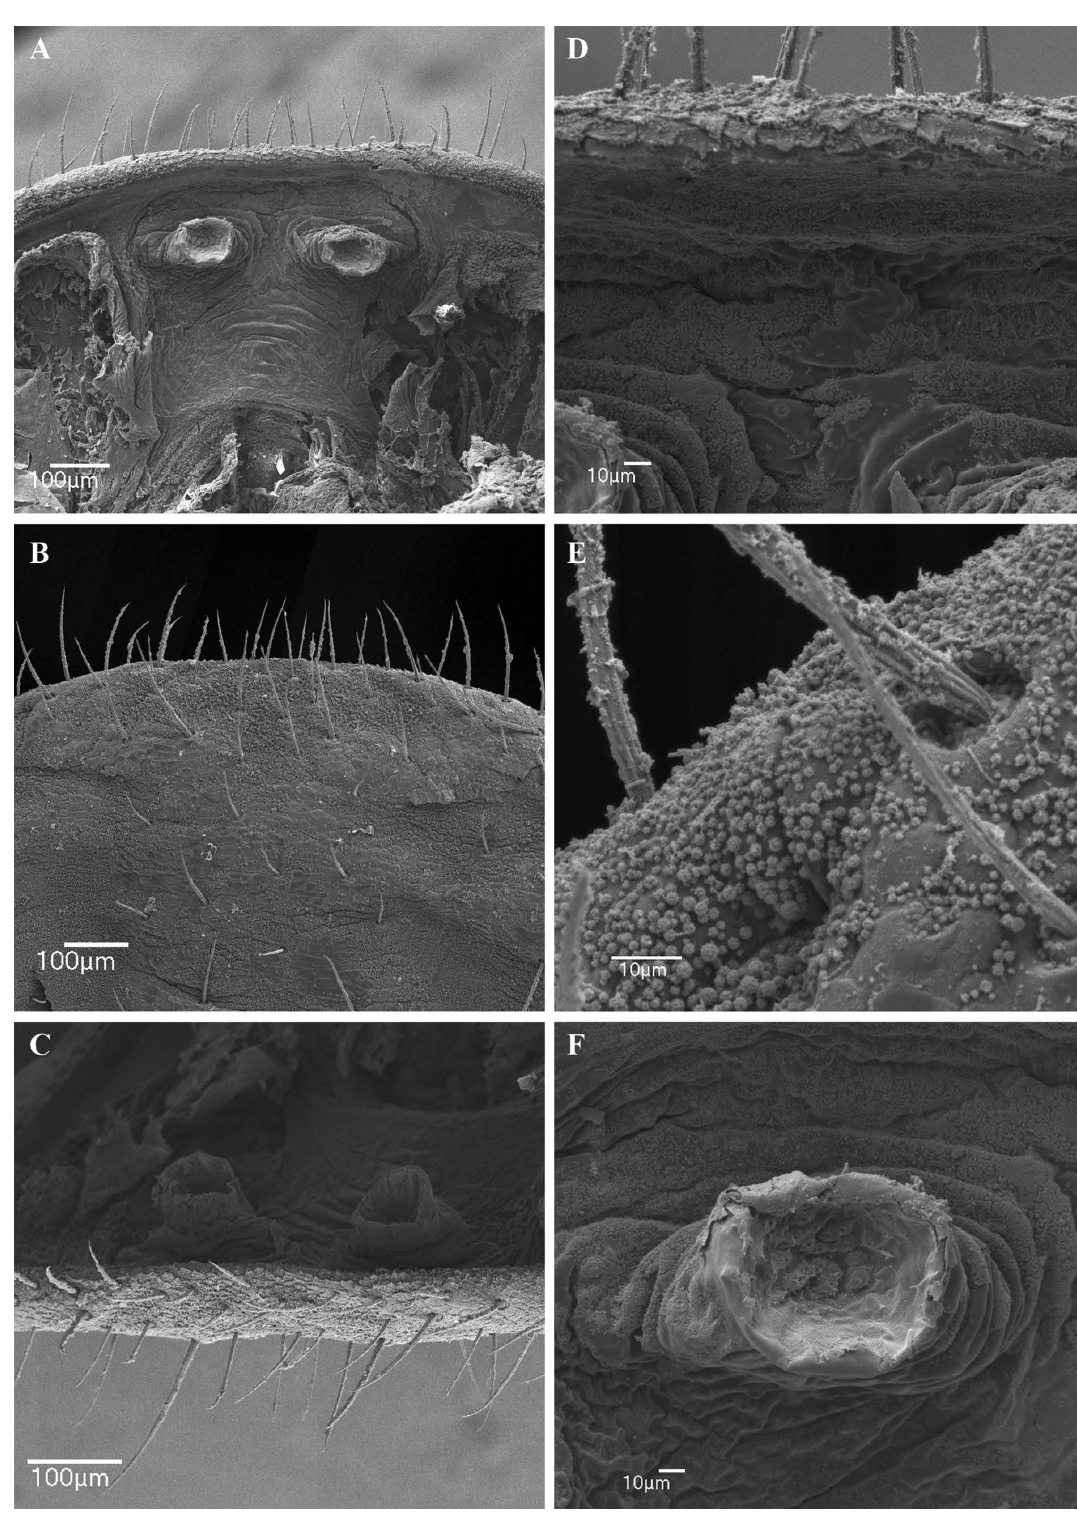
Fig. 55. Charinus cearensis sp. nov. (CHNUFPI 1255), female gonopod. A . Sucker-like gonopod, dorsal view. B . Genital operculum, ventral view. C . Gonopods, posterior view. D . Genital operculum, between gonopods, dorsal view. E . Gland opening near lateral margin of genital operculum. F . Sinistral side of sucker-like gonopod,